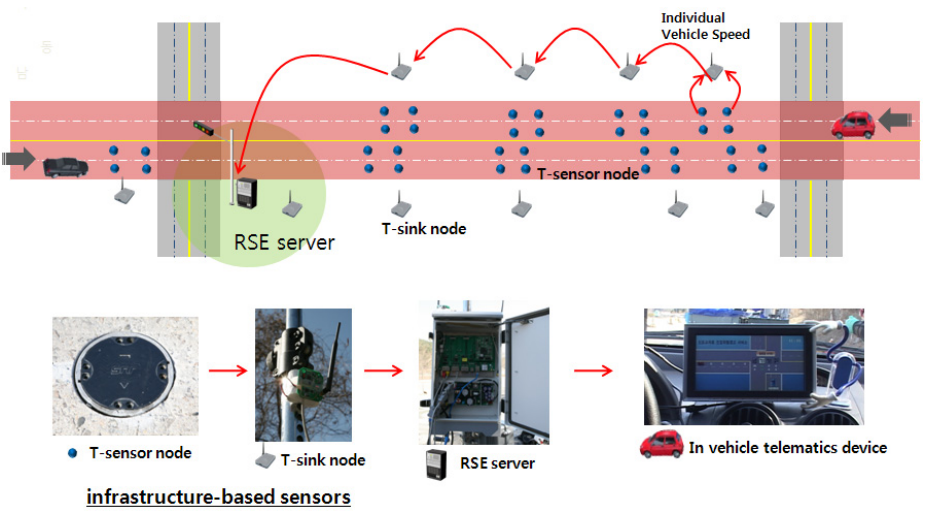
Figure 2. Examples of infrastructure-based sensors and procedures at an